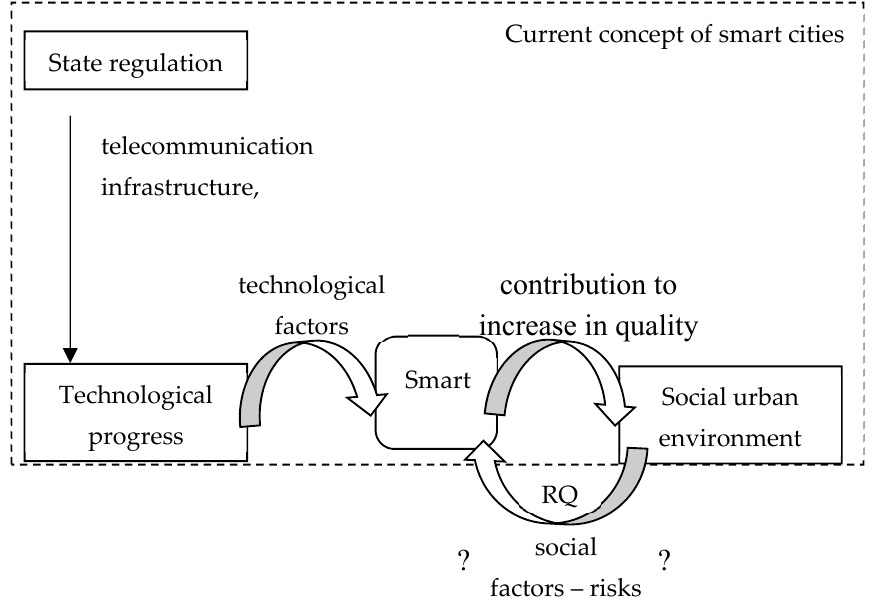
Figure 1. Causal connections of the creation and development of smart cities in their current concept. Source: authors.